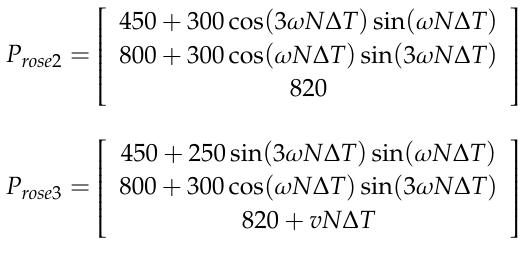
attitude error. ( e ) Norm of error vector. ( f ) Joint velocities of the